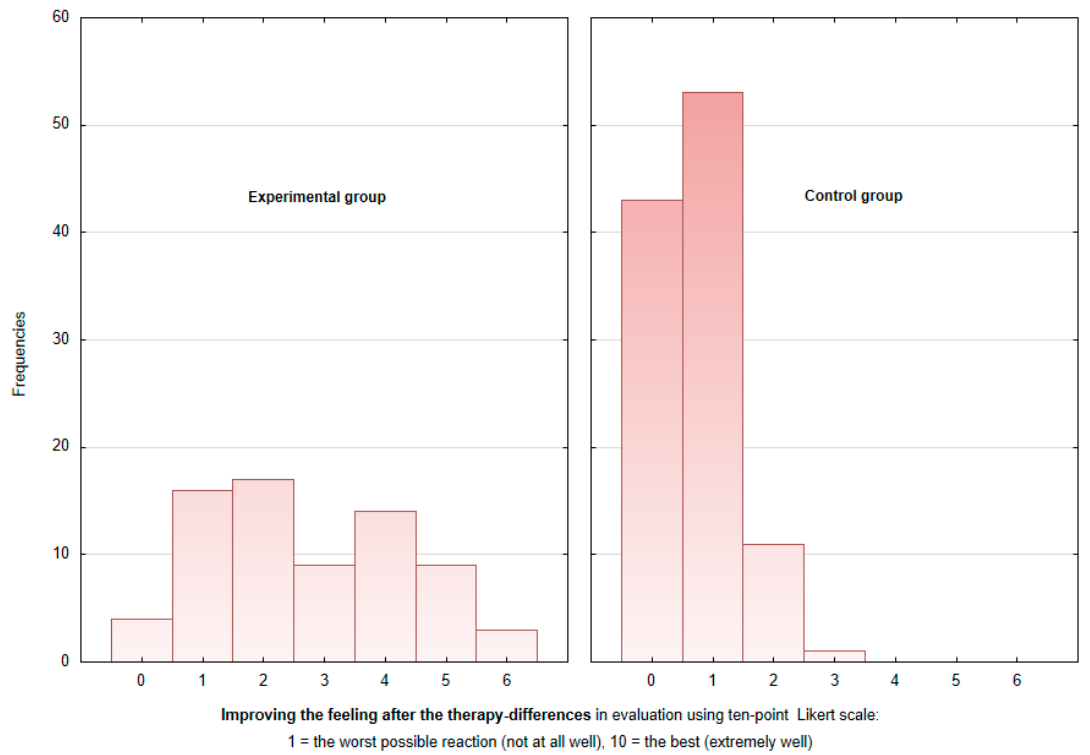
Figure 4. Subjective assessment of the well-being di ff erences between pre- and post-session in the experimental and control groups.